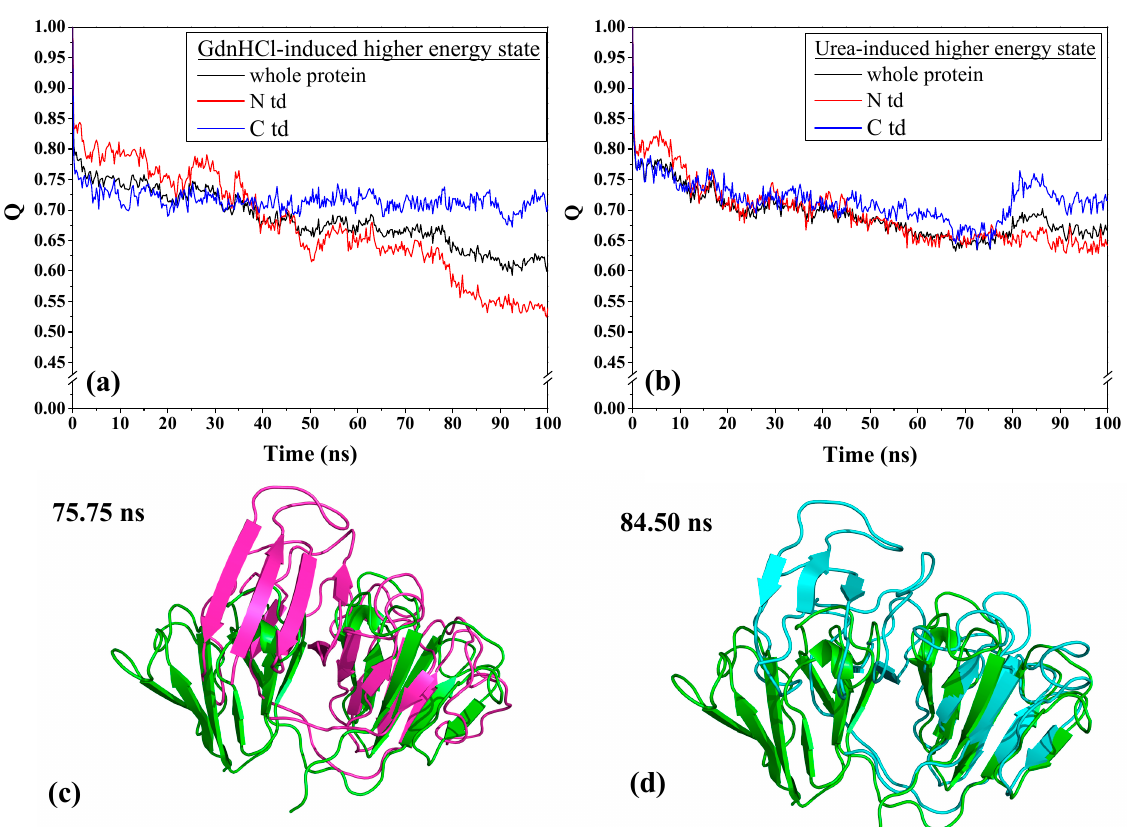
0.70 till the end of simulation time.